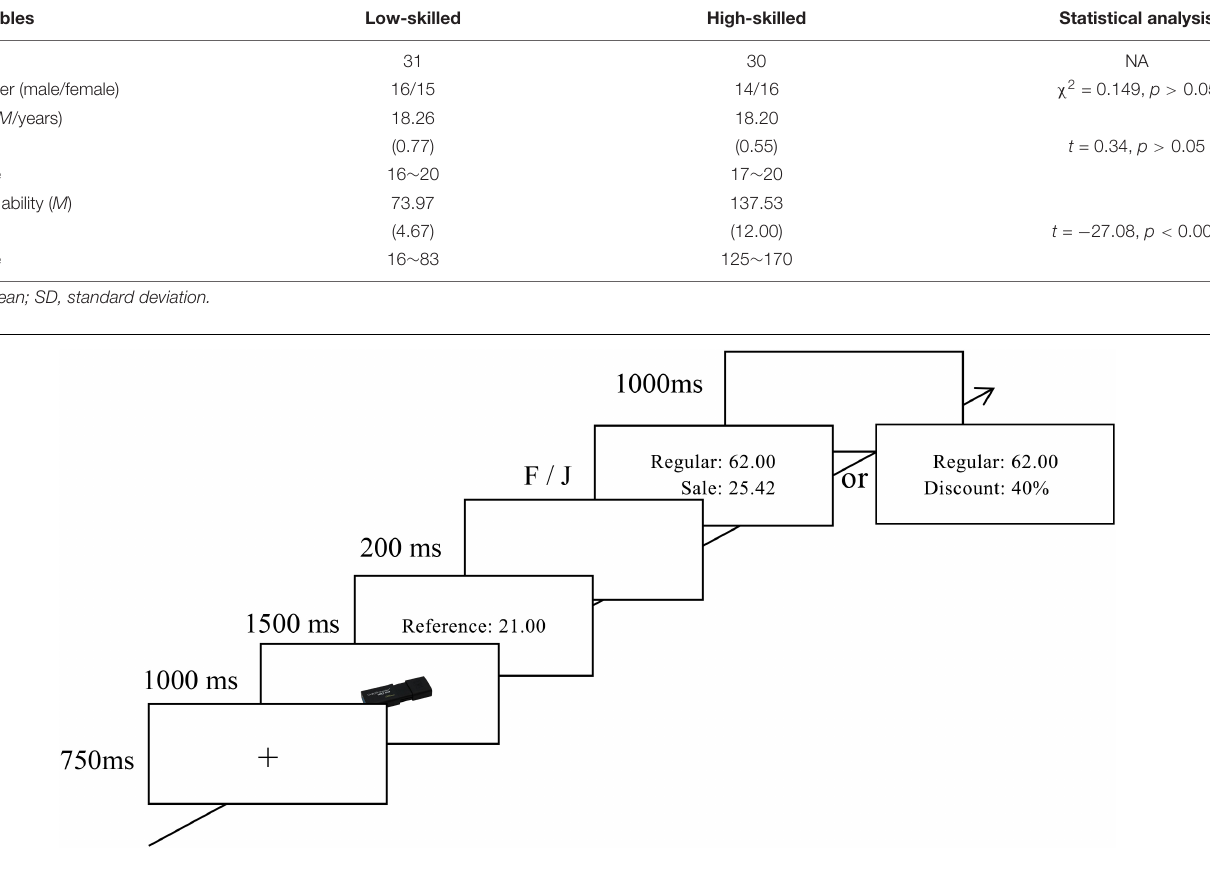
and used later for referencing. A bandpass filter was set to 0.05– 100 Hz, with a sampling rate of 1,000 Hz. The impedances of all electrodes were kept below 10 k (cid:127)